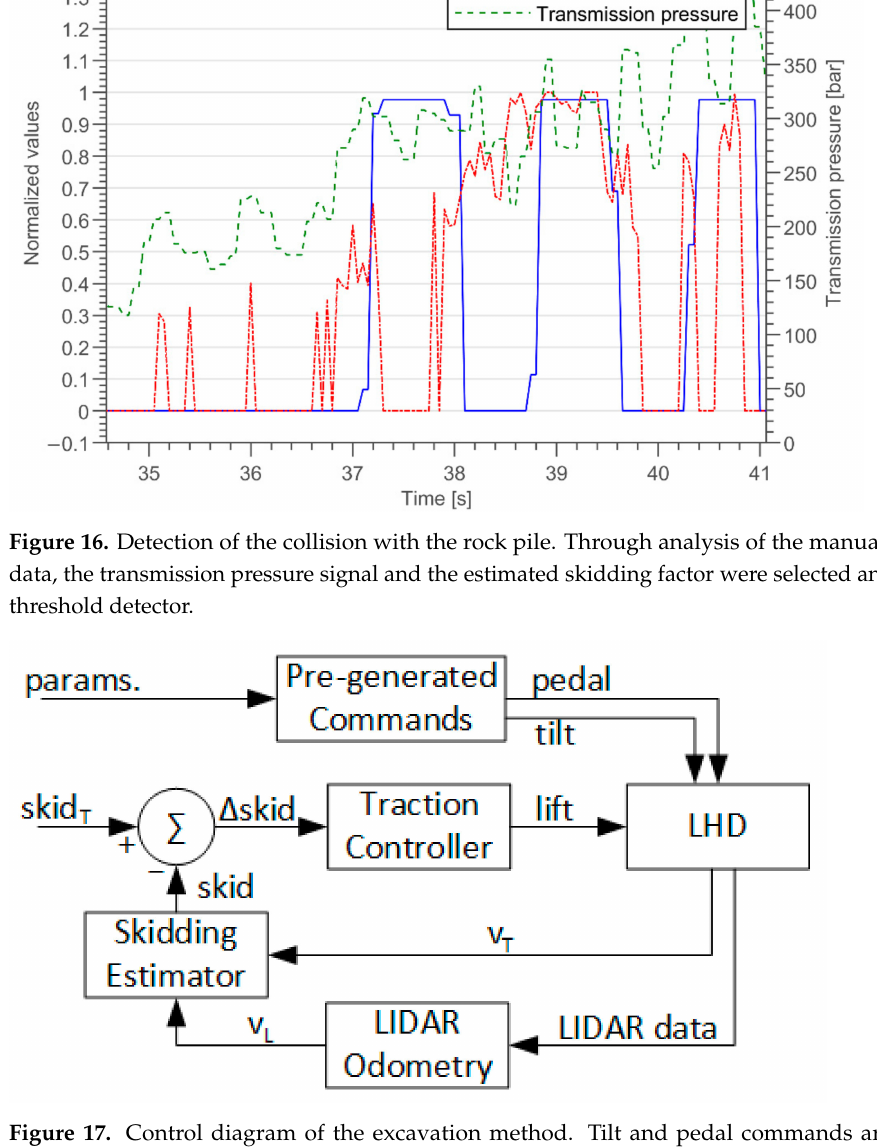
Figure 17. Control diagram of the excavation method. Tilt and pedal commands are predeter- mined from the human operator control method. The lift command is adjusted depending on the detected machine skidding, which is in turn estimated from the LIDAR odometry and machine tachometer